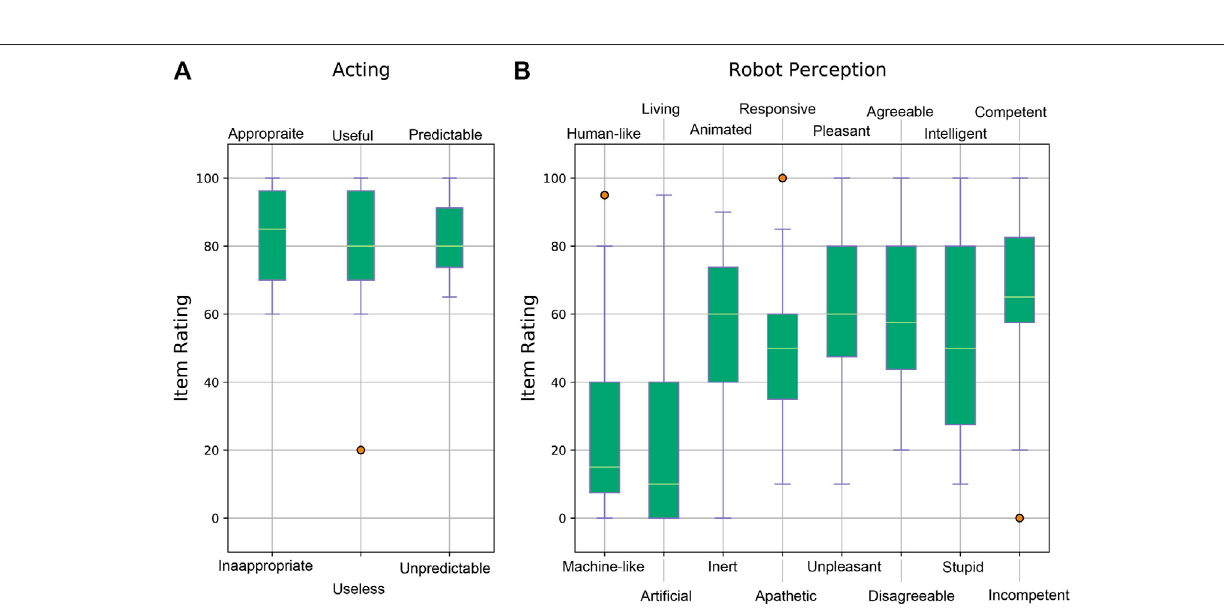
Frontiers in Robotics and AI |